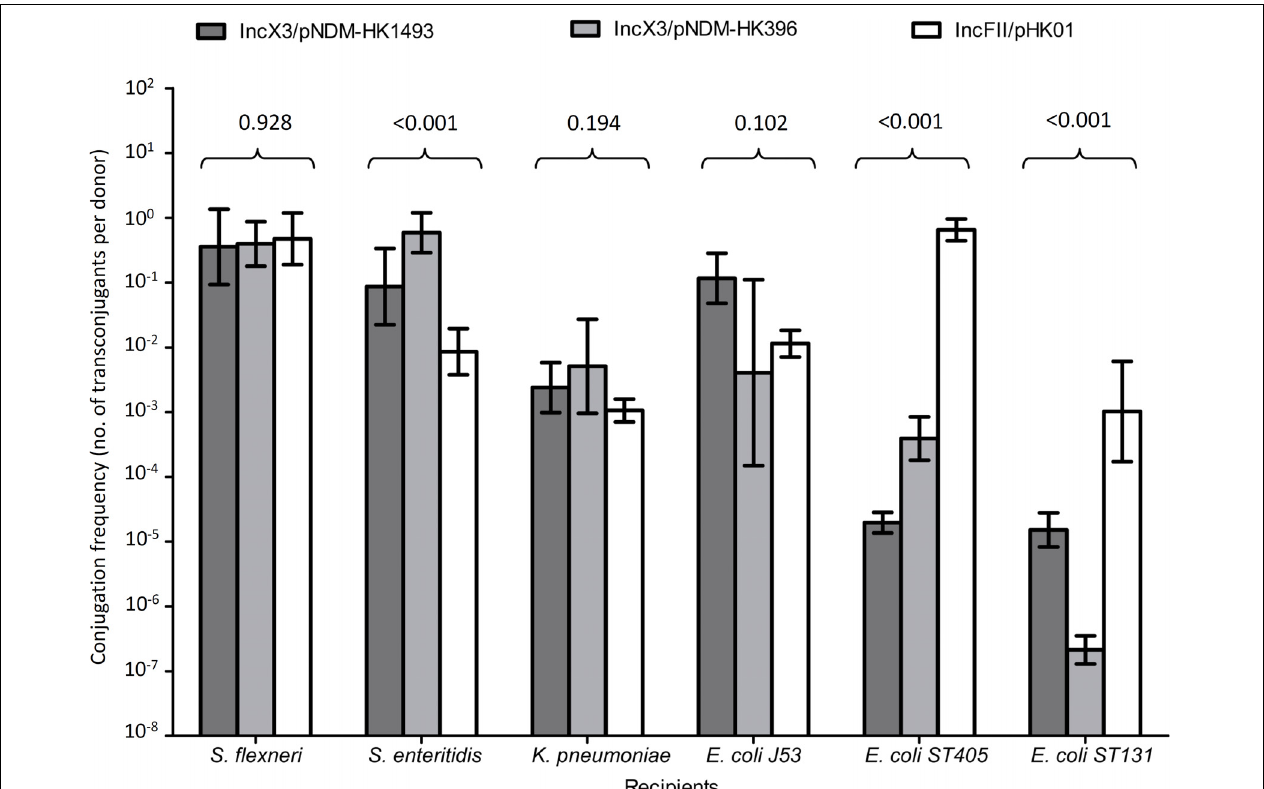
FIGURE 2 | Conjugation frequencies of IncX3 and IncFII plasmids to six recipients of different species. The donor E. coli strains for the IncX3 plasmids (pNDM-HK1493 and pNDM-HK396) were CRE1493 and CRE396, respectively, while for the IncFII (pHK01) plasmid was combat2D2. The histograms show means and standard deviations (error bars). Conjugation frequencies were logarithmically transformed prior to statistical analysis.